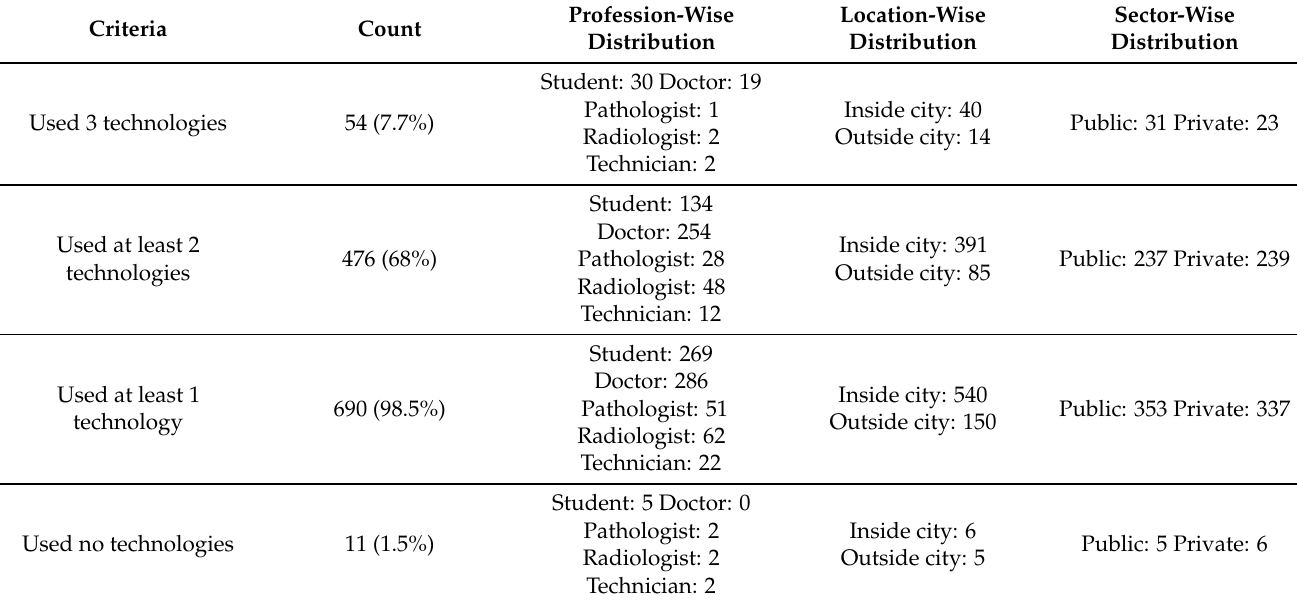
Table 1. Respondents who have used a computer, digital health applications and/or AI/CAD